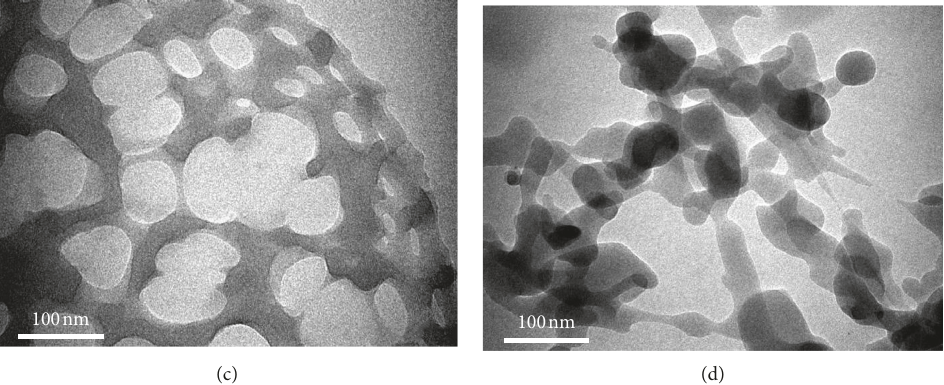
Figure 4: The morphology of the (qz) 4 NiPcs 4a–d samples prior to bacterial activities. TEM representative images of (a) 4a , (b) 4b , (c) 4c , and (d) 4d . The samples show the different morphological features for different samples. All scale bars are 100nm. Table 1: Minimum inhibitory concentration (MIC) and minimum bactericidal concentration (MBC) of (qz) Compounds